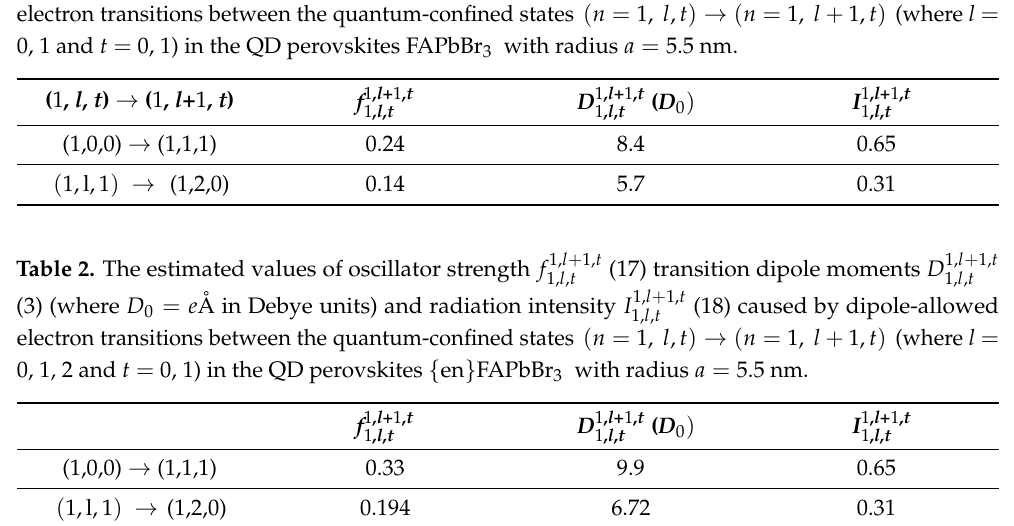
(17), transition dipole moments D 1, l + 1, t 1, l , t (18) caused by dipole-allowed 1, l , t